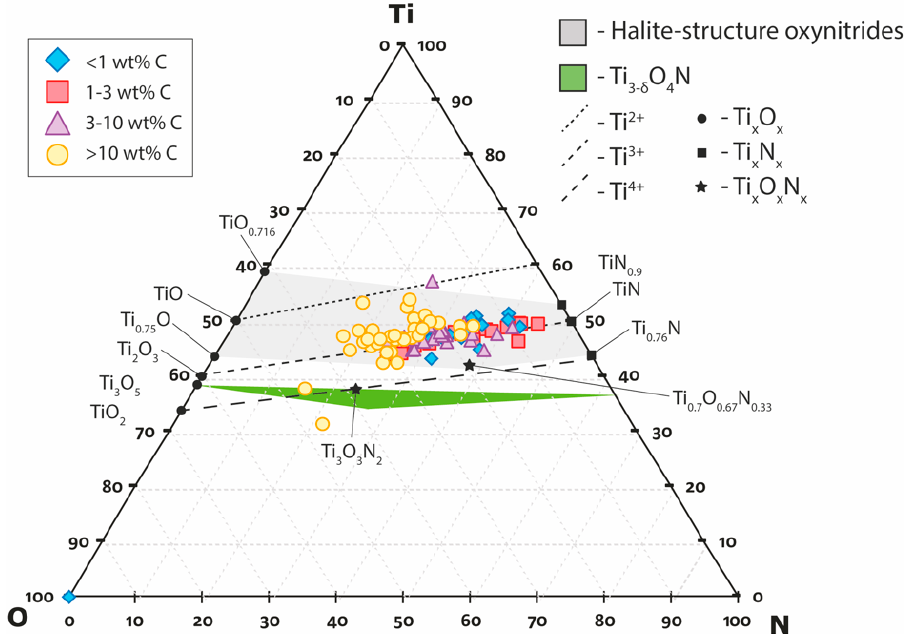
Figure 10. Phase space of Ti oxynitrides, after [25], showing distribution of analytical data; individual points are color-coded to show carbon contents. Phases in the green field would have a pseudo- brookite structure. Dashed and dotted lines define substitutions of Ti 2+ , Ti 3+ and Ti 4+ ; the scatter of analytical data suggests that Ti is Ti 3+ in most grains, and a mix of Ti 3+ and Ti 2+ in